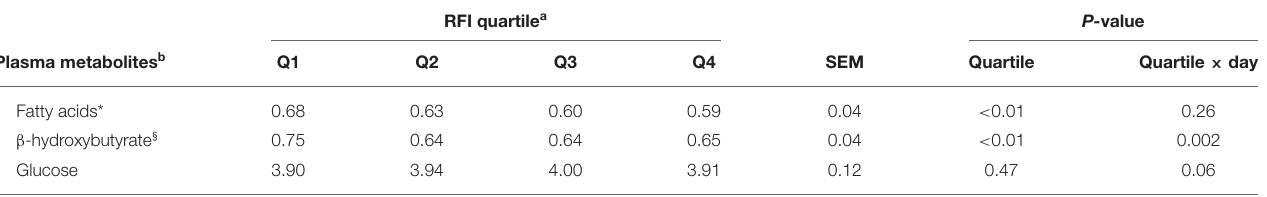
TABLE 2 | Association of quartiles of residual DM intake (RFI) and plasma metabolites in Holstein cows.